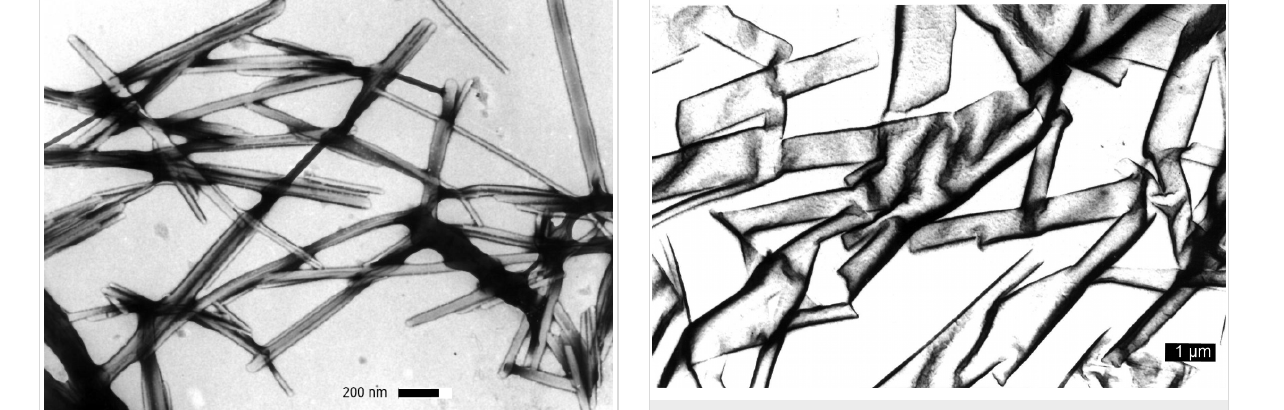
Figure 4: TEM images (PWK staining) of: ( S , R ) -1b toluene gel showing the presence of short tape like aggregates.